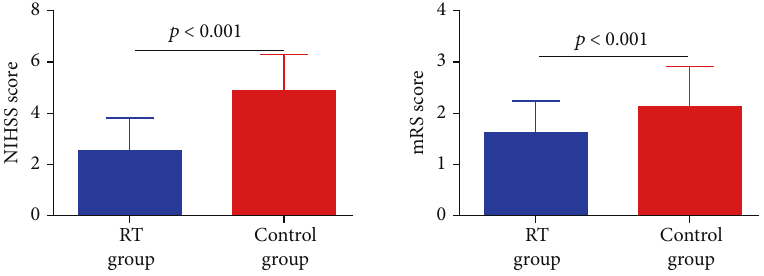
Figure 2: Prognosis of ischemic stroke patients in RT and control group. Data were expressed by median (range) and analyzed by Mann – Whitney U test. All data were nonnormally distributed. Table 2: Correlation analysis among IL-11, NIHSS, and